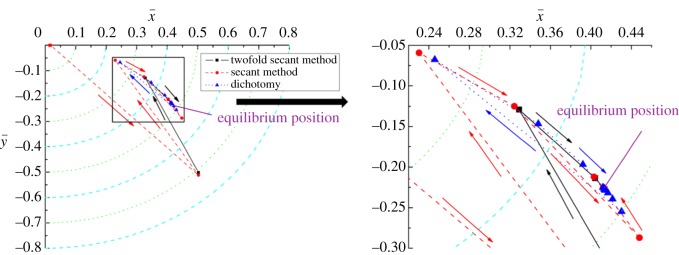
Convergence for the equilibrium position, Ωj = 2000 r min−1.